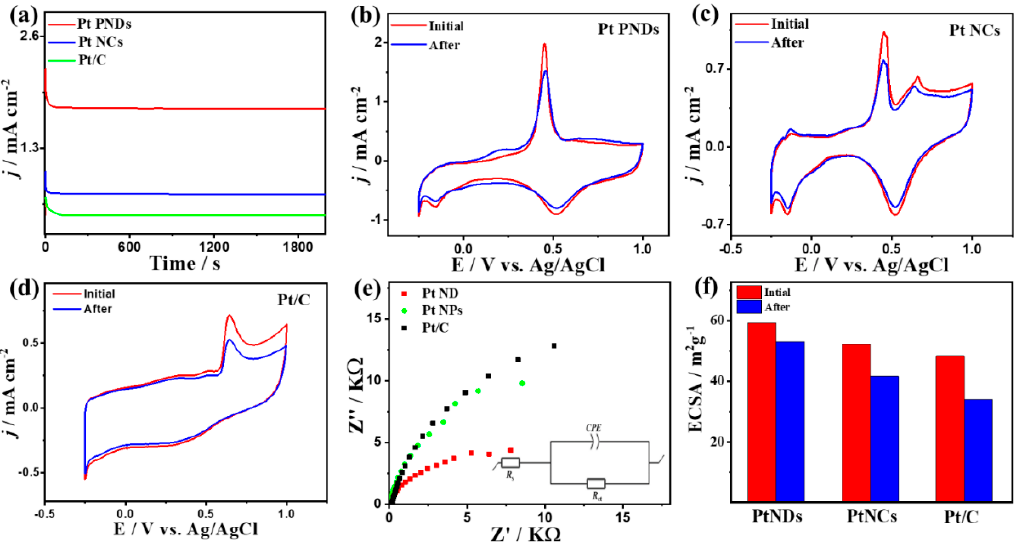
Figure 4. ( a ) CA tests measured on Pt NDs, Pt NCs, and Pt/C in CO-saturated 0.1 M HClO 4 . CV curves measured after CA on ( b ) Pt NDs, ( c ) Pt NCs, and ( d ) Pt/C. ( e ) EIS and ( f ) ECSA stability.